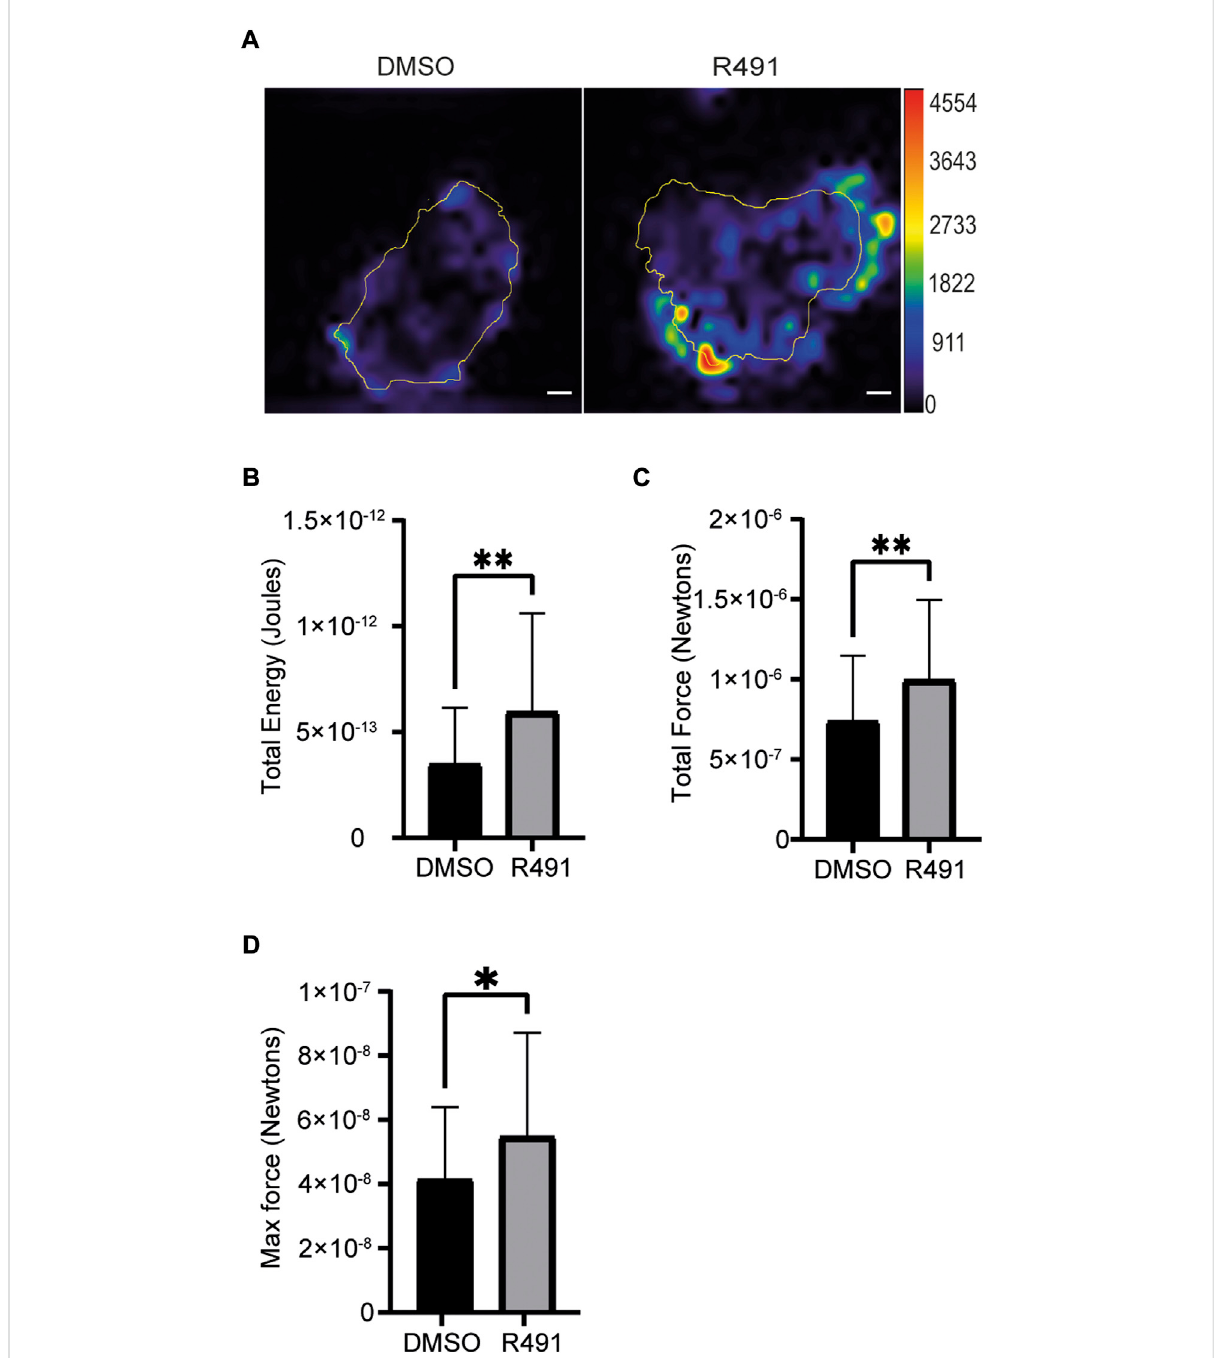
FIGURE 7 R491-treatment in BJ-Ras cells induces cellular contractile forces. (A) Representative traction force maps of control- and R491-treated cells with the color showing the magnitude of traction force (in pascals), as indicated in the color key. Quanti fi cation of (B) the total traction forces (traction forces integrated over cell area) exerted by the cells, (C) the total strain energy and the (D) maximum force is shown, as indicated. Traction force microscope measurements were taken from 5 µM DMSO- or R491-treated cells, from three biological repeats, n = 55 and n = 42 cells respectively. Data presented as mean ± SD. * p ≤ 0.05, ** p ≤ 0.01. Scale bars: 10